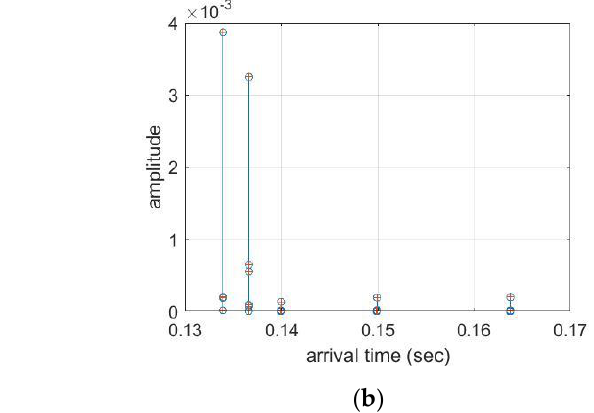
Figure 5. Simulation channel using the VirTEX simulator: ( a ) Ray tracing, ( b ) Channel impulse response.